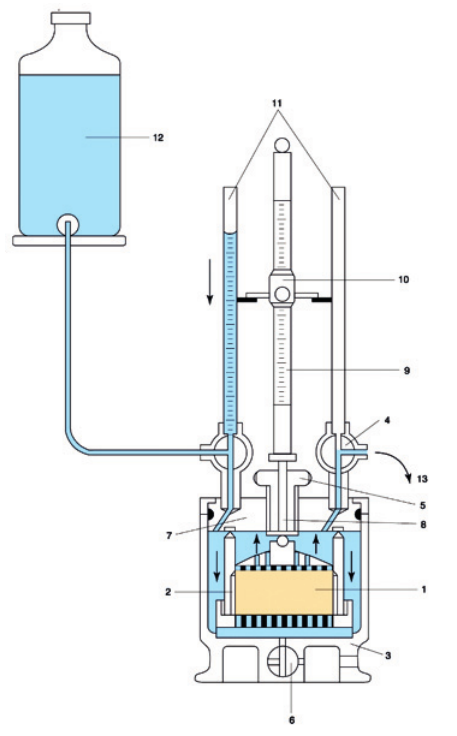
Fig. 1. A scheme of PV infiltrometer (permeameter): 1 – clay sample; 2– filtering chamber ring; 3 – a case; 4 – three-way faucet (tap); 5 – valve; 6 – two-way faucet (tap) for filling the infiltrometer with water; 7 – a case cover; 8 – thermometer; 9 – water level scale in piezometer; 10 – sliding marker; 11 – piezometers; 12 – a container for water; 13 – filtrate